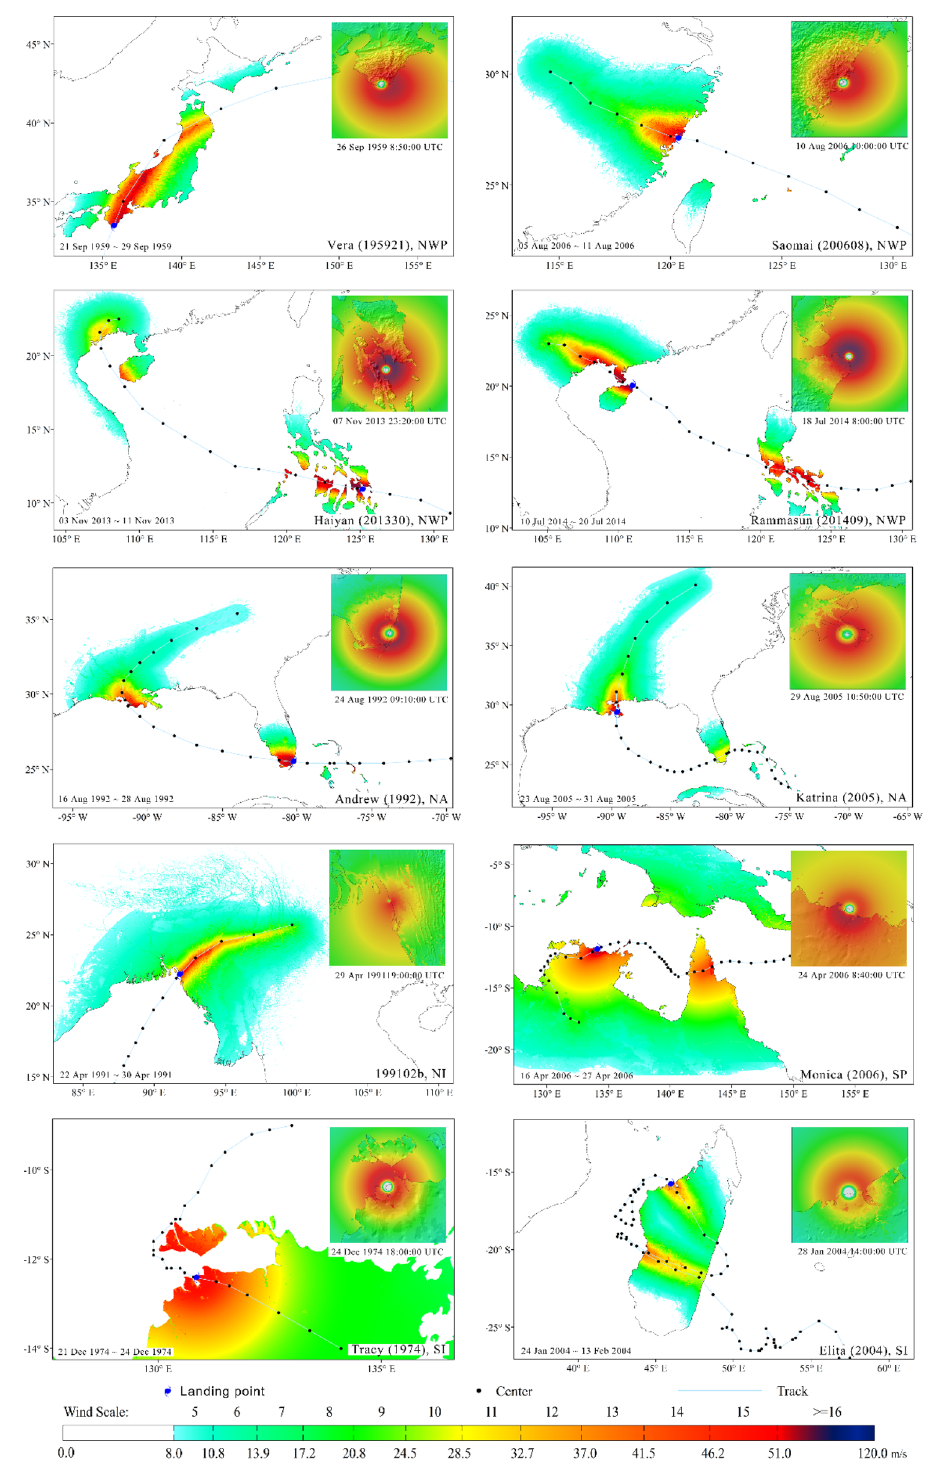
Fig. 8 Simulated snapshots